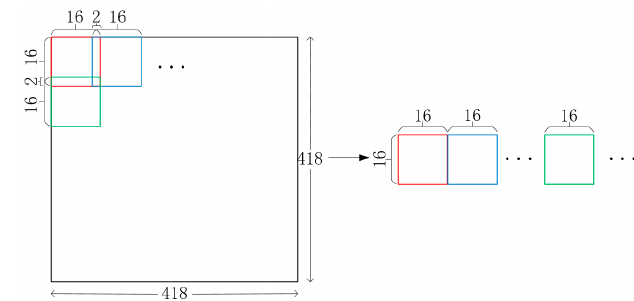
Figure 3. Data transmission strategy of the accelerator.